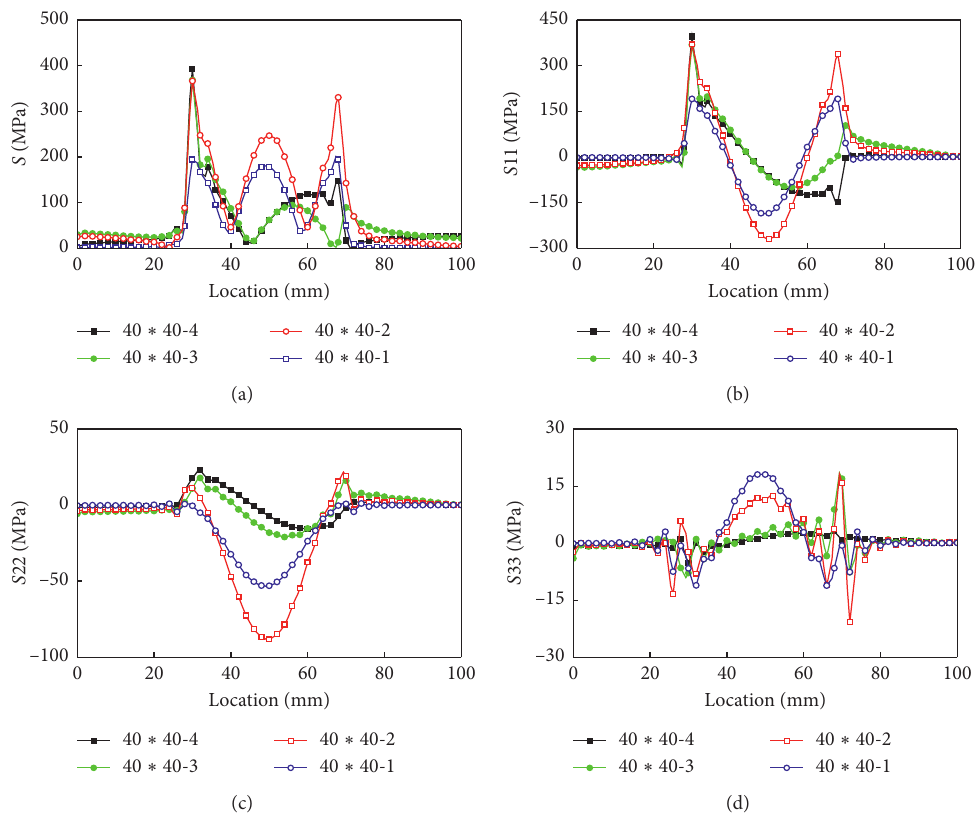
Figure 7: Value of overall stress in